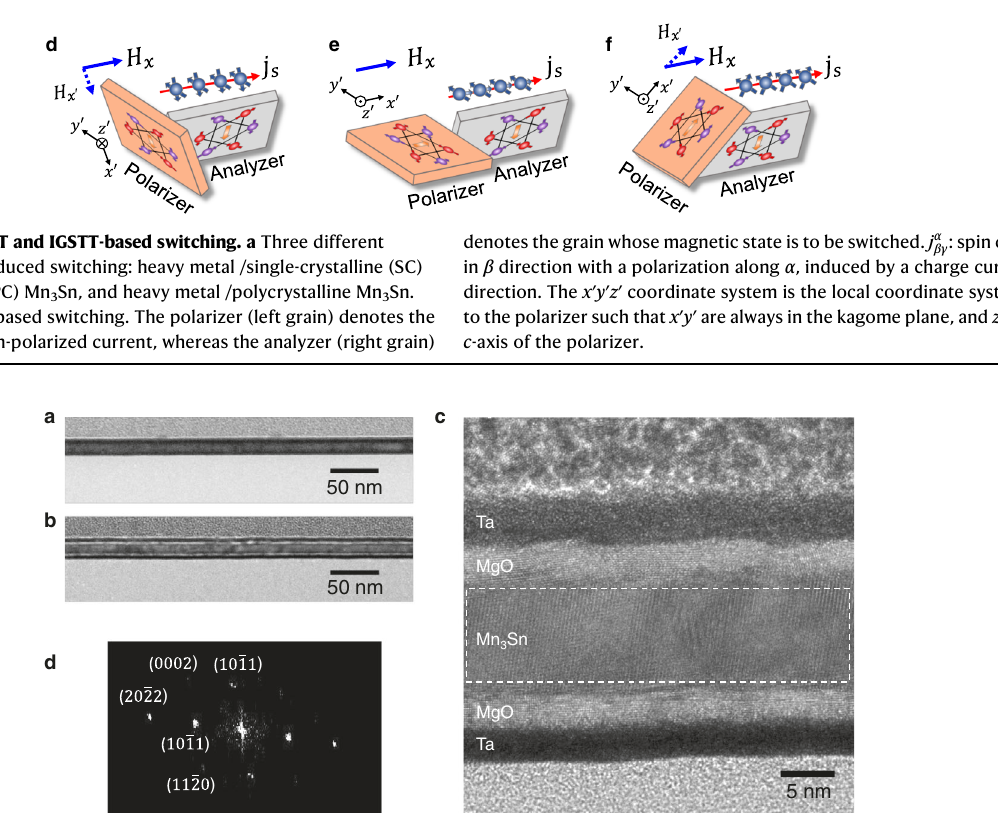
Fig. 6 | TEMimagesofMn 3 Sn. a , b Cross-sectionalTEMimages of Ta/Mn 3 Snand Ta/MgO(4)/Mn 3 Sn, respectively. c HRcross-sectionalTEM image ofTa/MgO(4)/Mn 3 Sn. d Electron diffraction pattern of the Mn 3 Sn layer in c .